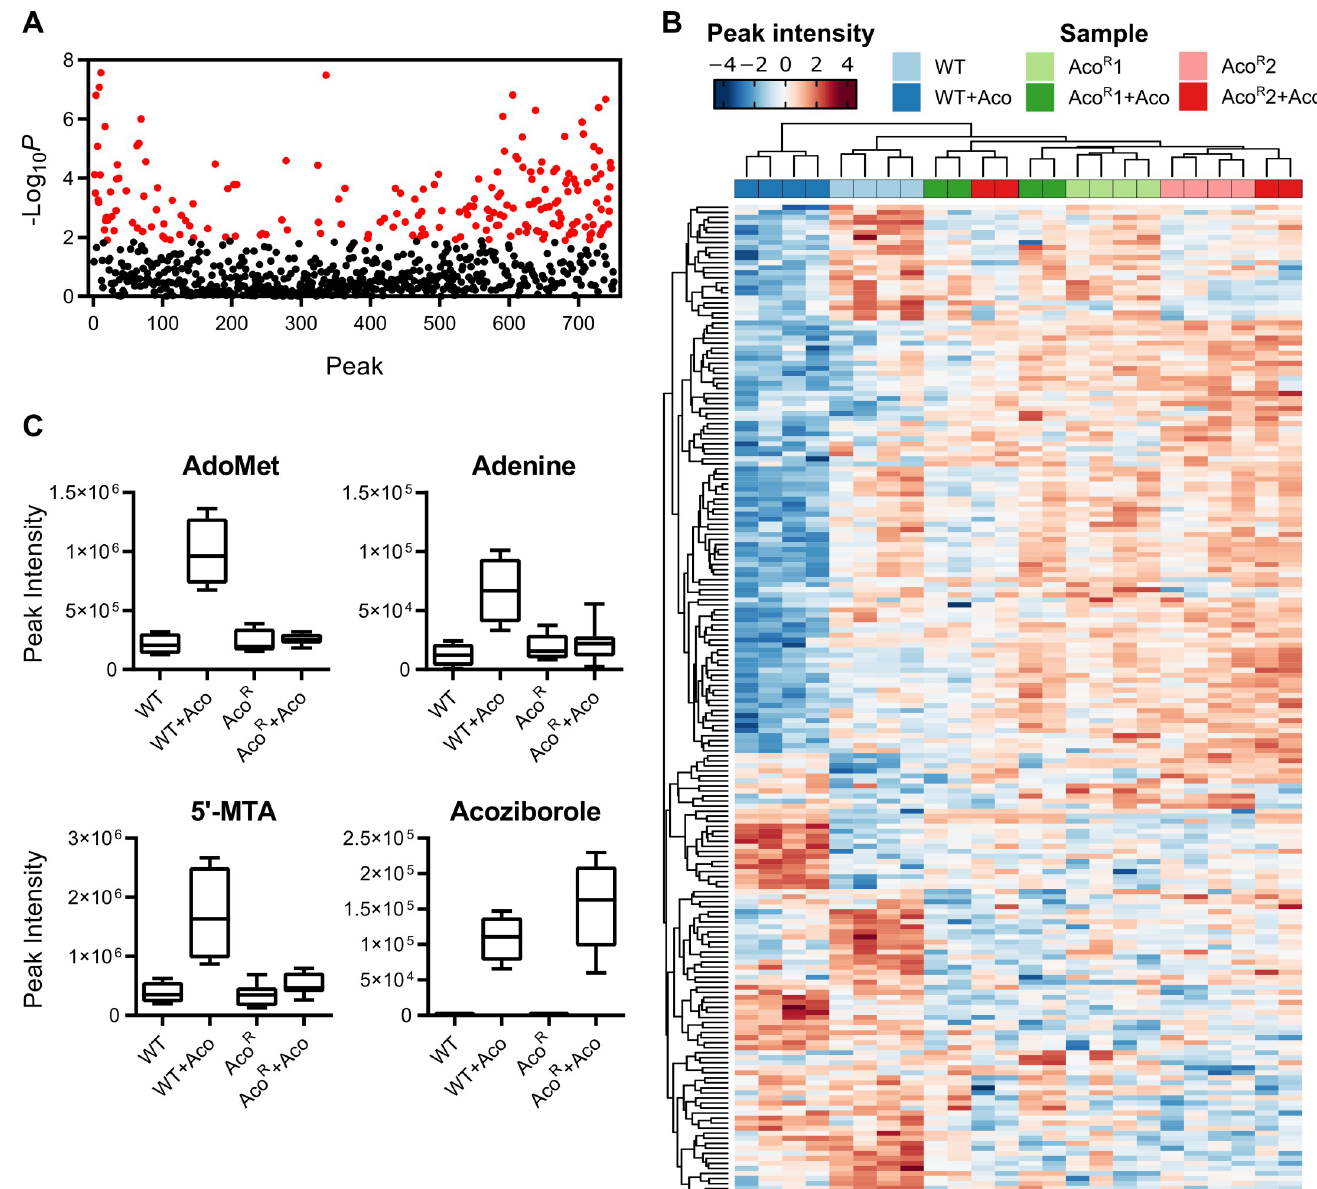
Fig 3. Metabolomics analysis of Aco R cells. A) Results of an analysis of variance (ANOVA) on 754 putatively identified metabolites. Each peak was assigned a number (S3 Table) for clarity, and significant metabolites (FDR < 0.05; 197 metabolites) are highlighted in red. B) Heat map of significantly altered metabolites (ANOVA, FDR < 0.05). LC-MS peak intensities were log transformed and auto-scaled (mean-centred, divided by the standard deviation for each metabolite). Both samples and metabolites were clustered, showing clear separation of the wild-type, acoziborole-treated samples from all other sample groups. C) AdoMet metabolism is significantly disrupted during acoziborole treatment in wild-type cells, but unchanged in Aco R cells irrespective of drug treatment. However, acoziborole is still detected in Aco R cell pellets. Abbreviations: Aco, acoziborole; AdoMet, S-adenosyl-L-methionine; 5’-MTA,